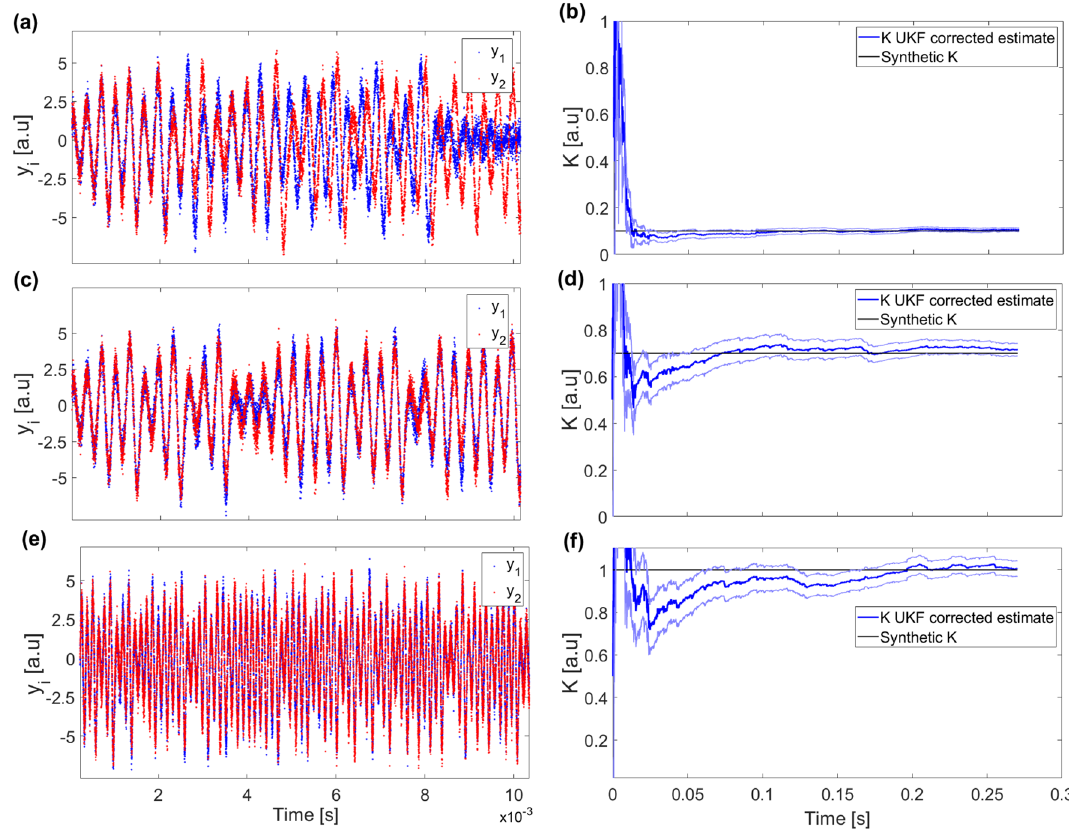
Figure 2. Left panels show the time series of y 1 ( t ) and y 2 ( t ) for two coupled nodes with strengths K = 0.1 ( a ), K = 0.7 ( c ) and K = 1.0 ( e ). Notice that in panels ( a ) and ( c ) the evolution of the variables shows some interaction but not fully synchronization, which is illustrated in panel ( c ). Right panels, ( b ), ( d ) and ( f ), respectively, show the evolution of the UKF estimation of the parameter K for each group of synthetic data shown of its left. The solid black line indicates the value of the synthetic K to be obtained by the UKF estimation. The blue line is the estimation output from the UKF. The blue lighter lines indicate the σ and − σ uncertainty bands defined by the square root of the estimate of the state covariance matrix for the parameter value K. The parameters used for these simulations and filtering are given in Table 1. Their duration is 100,000 time